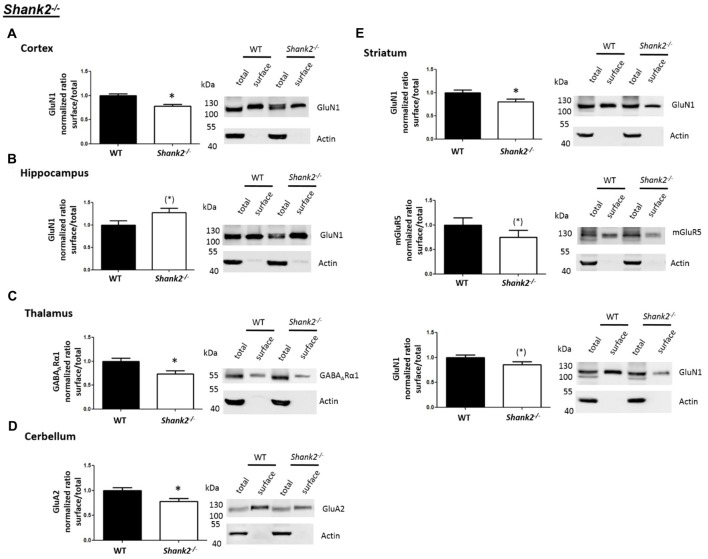
Analysis of cell surface glutamate and GABA receptor subunits in autism spectrum disorder (ASD) related brain regions of Shank2−/− mice. (A–E) Representative WBs showing band intensities of total protein and cell surface sample in cortex (A), striatum (B), hippocampus (C), thalamus (D) and cerebellum (E) of wildtype and Shank2−/− mice reveal a downregulation of cell surface glutamate receptor subunits in Shank2−/− mice. Immunodetections were carried out with antibodies directed against GABAARα1, GluA2, GluN1, GluA1, mGluR5 and actin. For GABAARα1, GluA2, and actin all brain regions were analyzed. For GluN1 all brain regions except the cerebellum were analyzed. For GluA1 all brain regions except the thalamus and cerebellum were analyzed. For mGluR5 only the hippocampus was analyzed. Only statistically significant data (p < 0.05; see below) or data with strong trends (p < 0.10; see below) is shown. To the left of each representative WB, the respective quantification of the surface/total ratio is shown. Vertical axis shows the mean fold change vs. the wildtype control (control set to a value of 1). Error bars are SEMs. n ≥ 5 per group. *p < 0.05, (*)p < 0.10.